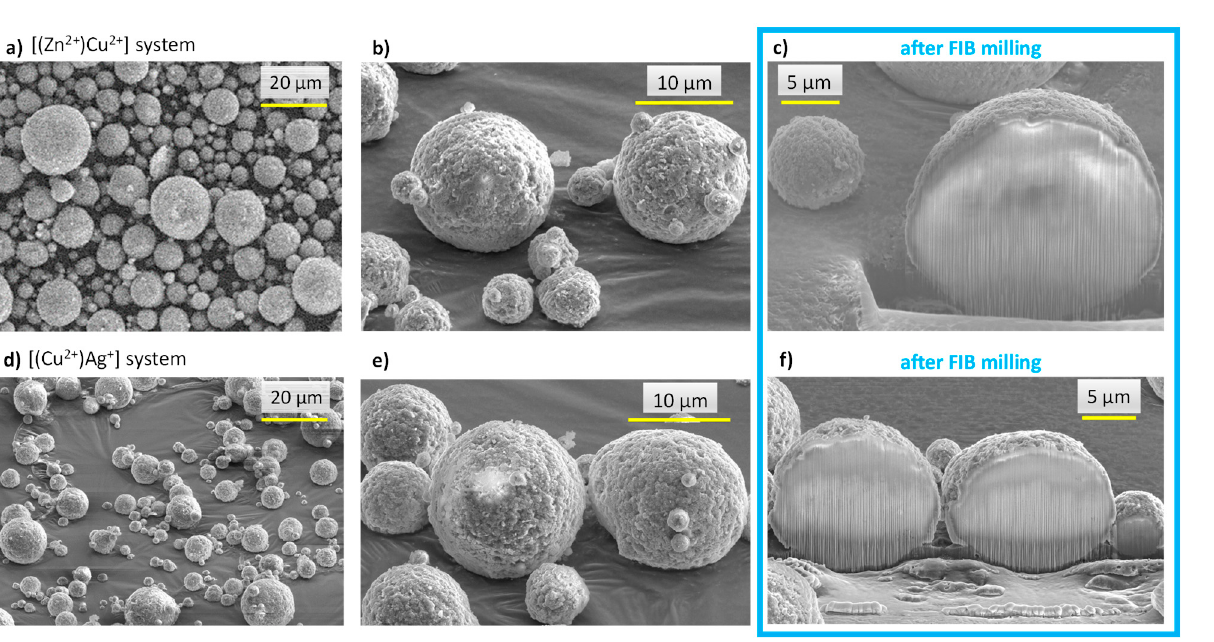
Figure 5. SEM micrographs of spray-dried core-shell particles: images ( a – c ): [(Zn 2+ )Cu 2+ ] system, images ( d – f ): [(Cu 2+ )Ag + ] system. Images ( c , f ) refer to observations made after FIB milling.